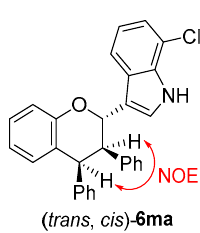
Figure 8. Relative configuration of 6ma